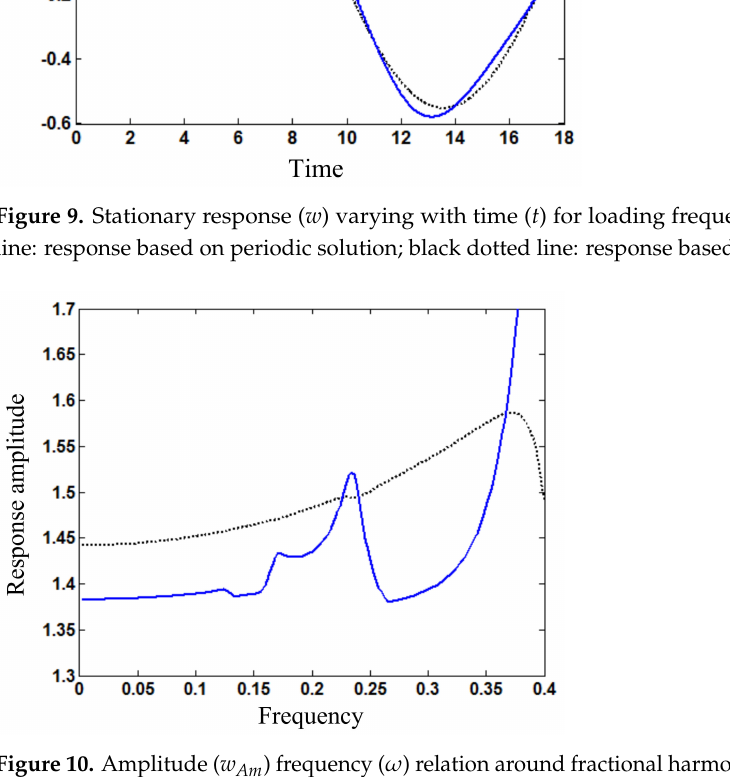
Figure 10. Amplitude ( w Am ) frequency ( ω ) relation around fractional harmonic resonance for loading amplitude F s 1 = 1.7 (blue solid line: response based on periodic solution; black dotted line: response based on first harmonic